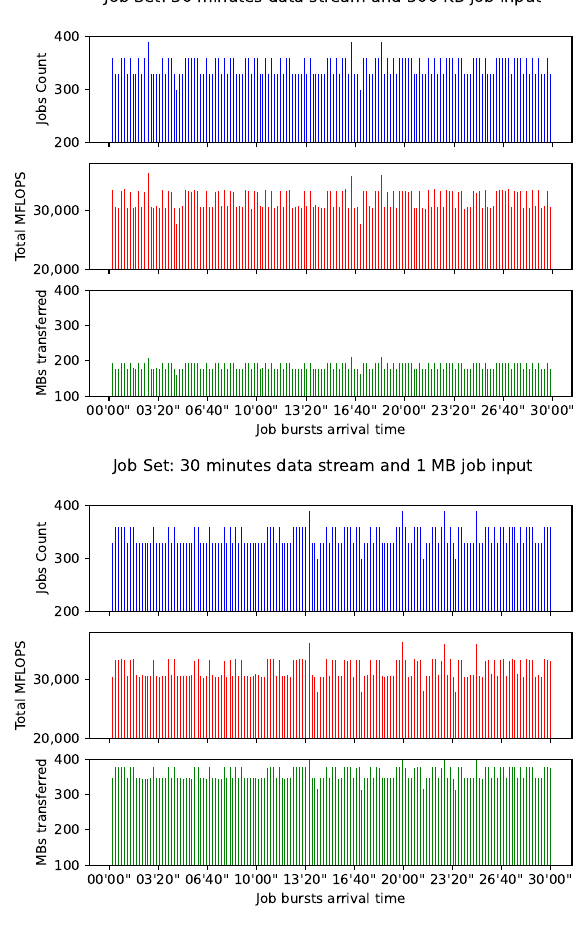
Figure 2. Job set